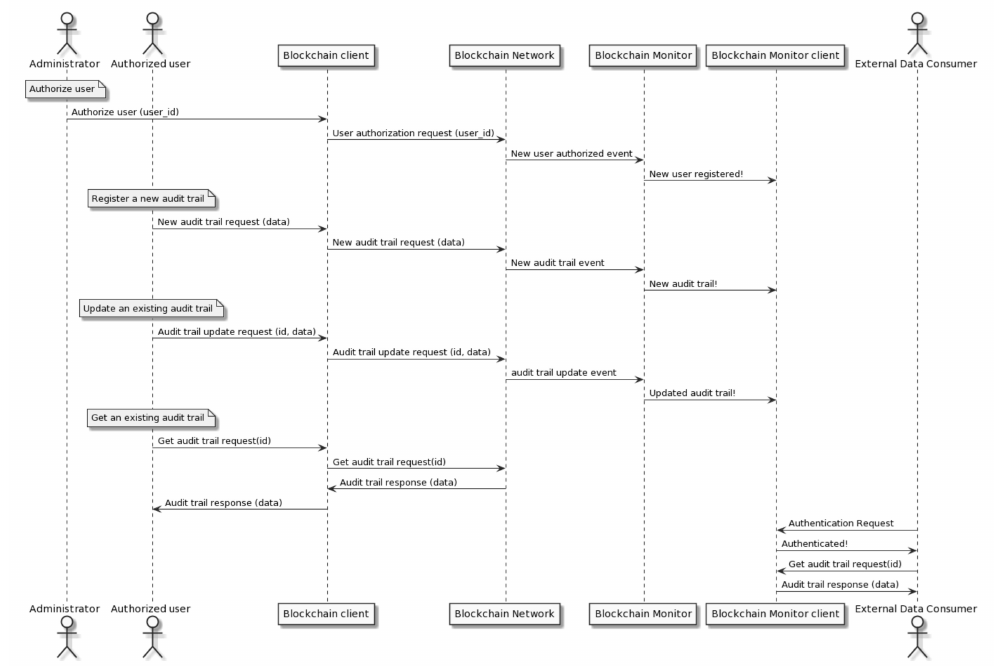
Figure 6. Audit trail mechanism operation sequence